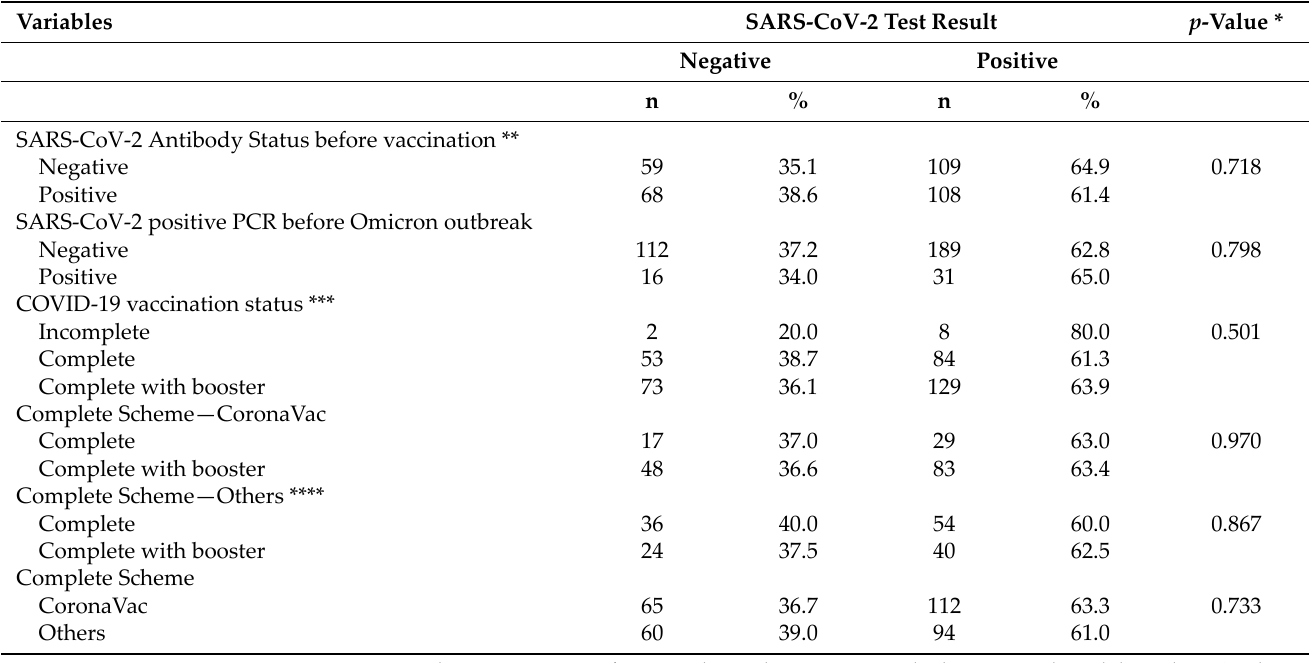
Table 7. Status of SARS‑CoV‑2 IgA/IgG and vaccine of IFF/Fiocruz workers according to SARS‑CoV‑2 test